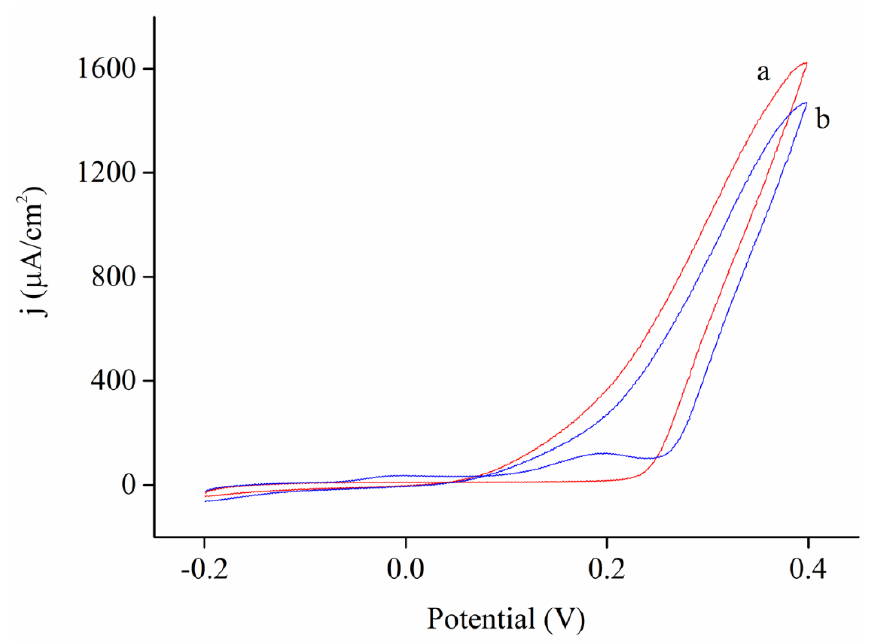
Figure 8. The CV profiles for pristine Ni inverse opals in a) 0.1 M PBS and b) 0.1 M PBS containing 194 μM ascorbic acid (AA), 194 μM dopamine (DA), and 134.4 μM uric acid (UA).